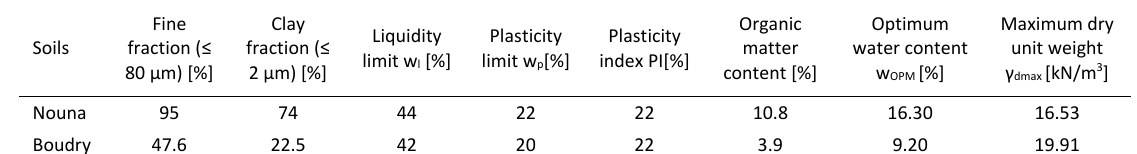
Table 1: Geotechnical identification parameters of the studied soils